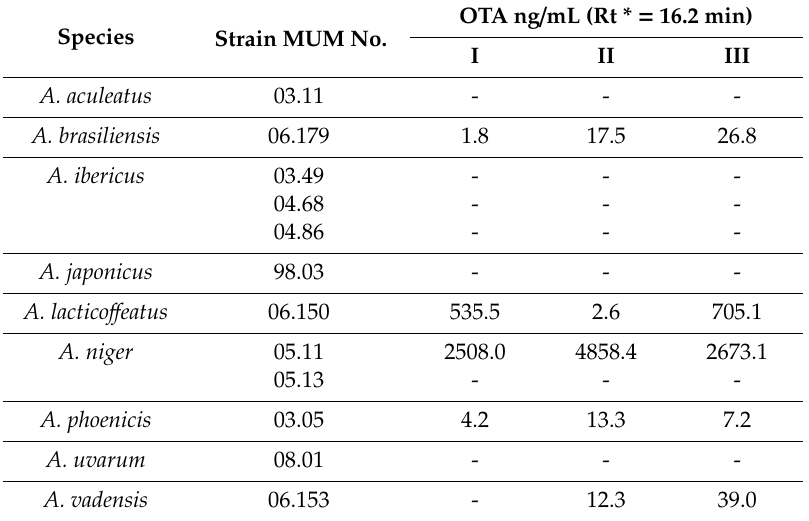
Table 5. Concentrations of ochratoxin A (OTA) determined for 12 Aspergillus strains at di ff erent preservation time points (before (Time I), after 2 weeks (Time II) and 4 weeks (Time III) of freeze-drying). Species Strain MUM